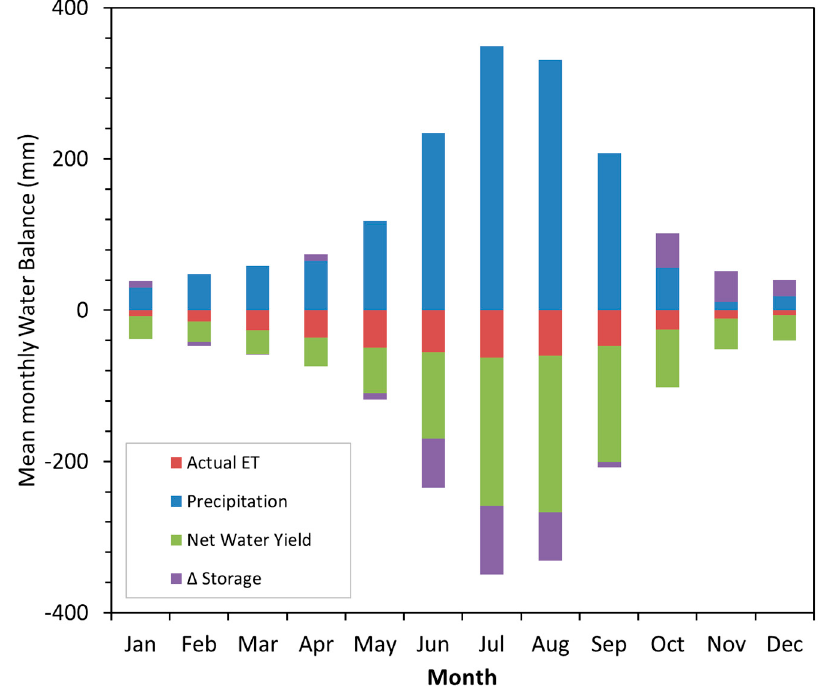
Figure 9. Mean monthly simulated (1983–2012) water balance in Budhigandaki basin.